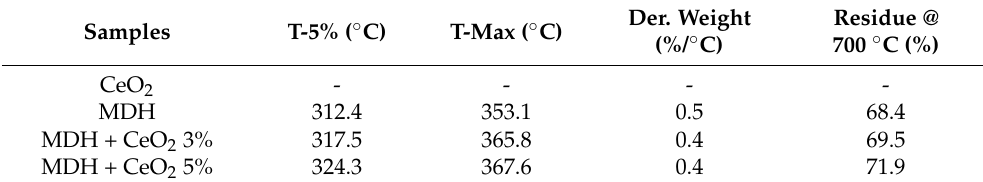
Table 2. TGA Results of the Pure and Modified